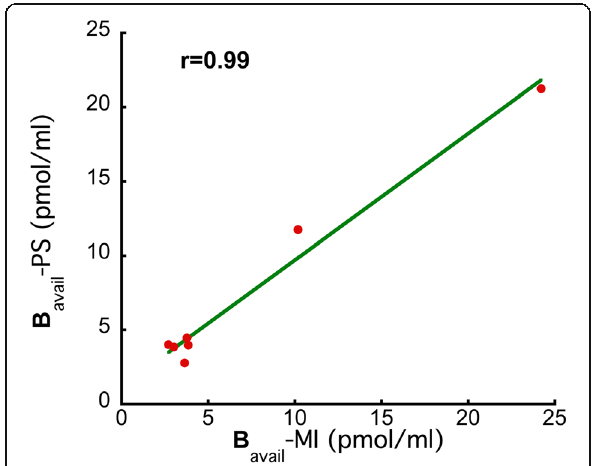
Fig. 6 Correlation between the B avail values estimated with the multi- injection approach (horizontal axis) in three rats and the corresponding values estimated with the partial saturation approach (vertical